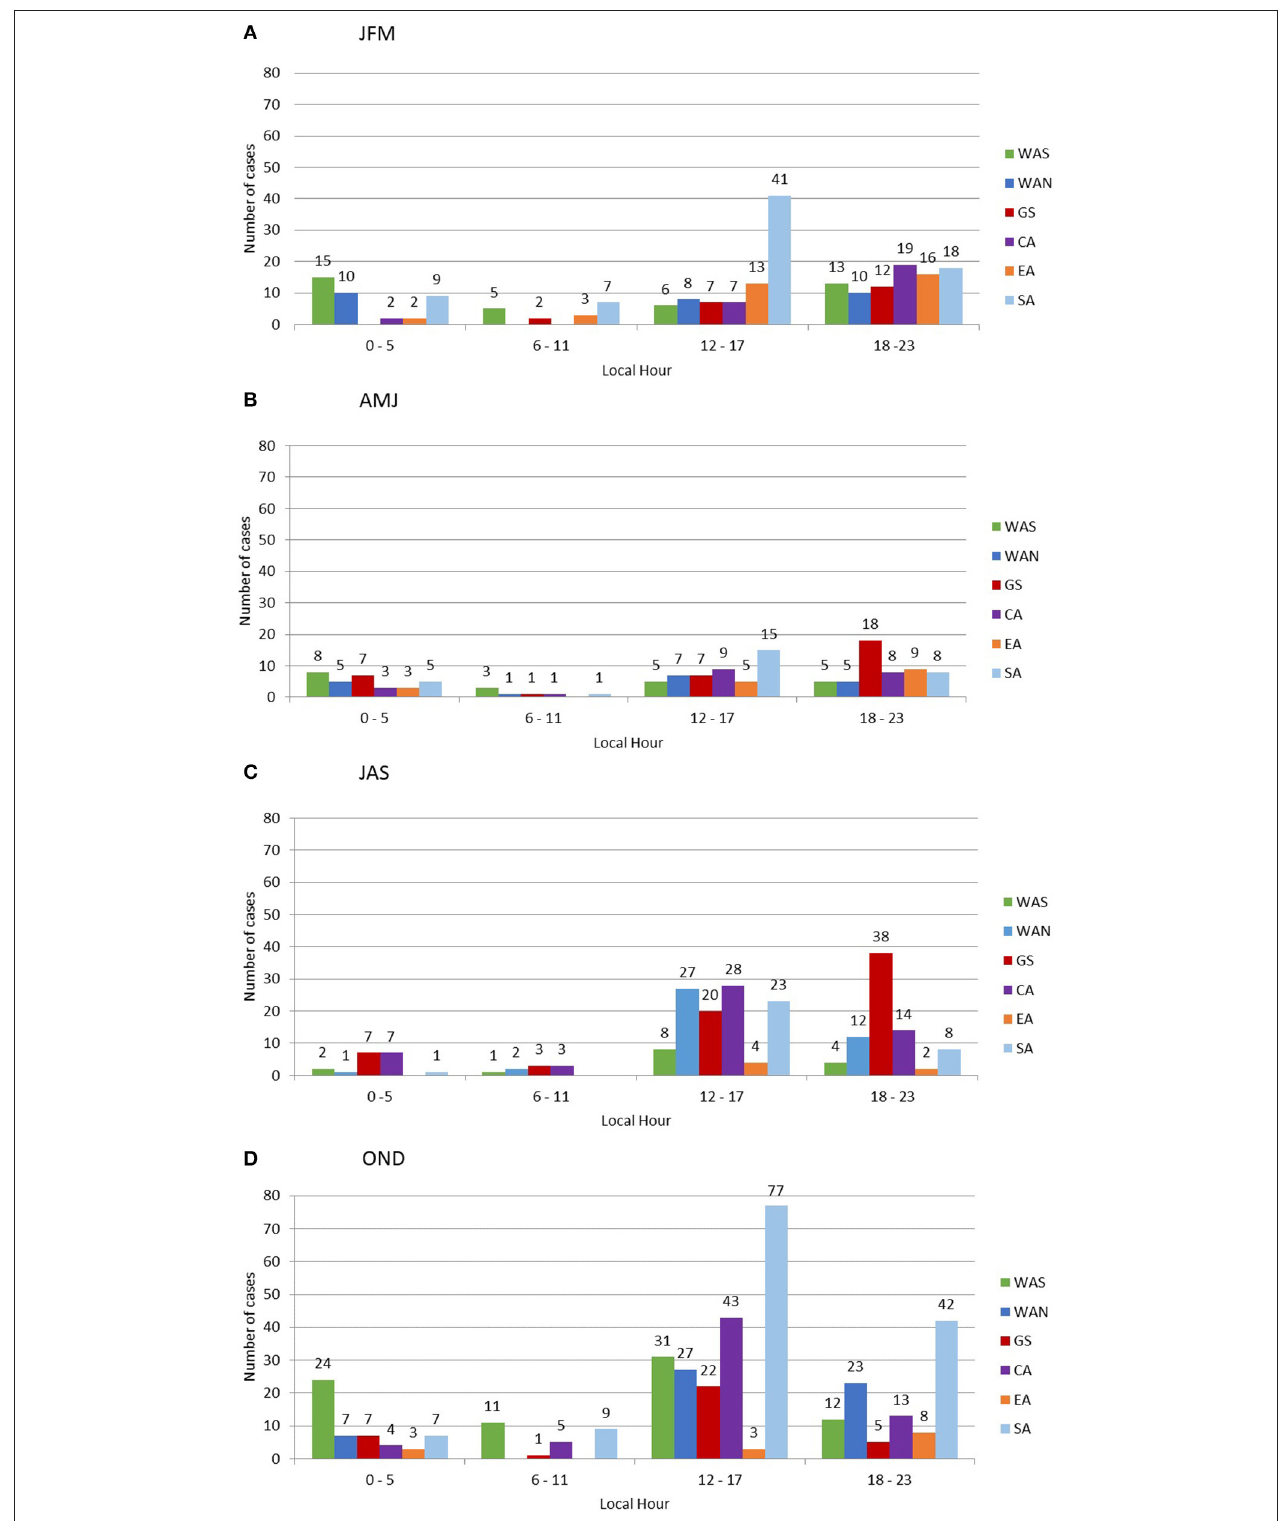
FIGURE 6 | Hourly distribution (LT) of the number of cases of potentially severe convection cases for subset 4 for each subregion and each trimester for 1998–2012, where (A) JFM, (B) AMJ, (C) JAS, (D) OND.